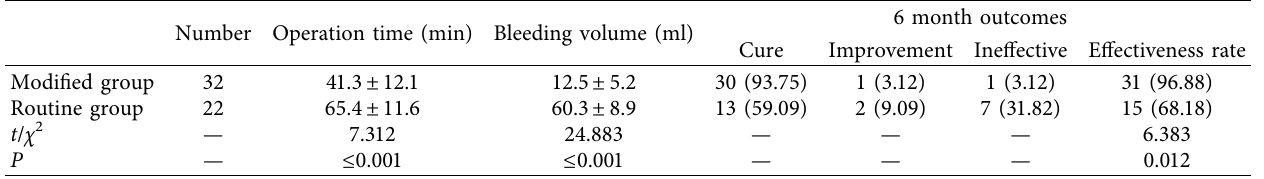
Table 2: Clinical outcomes in patients who underwent modifed and routine endoscopic